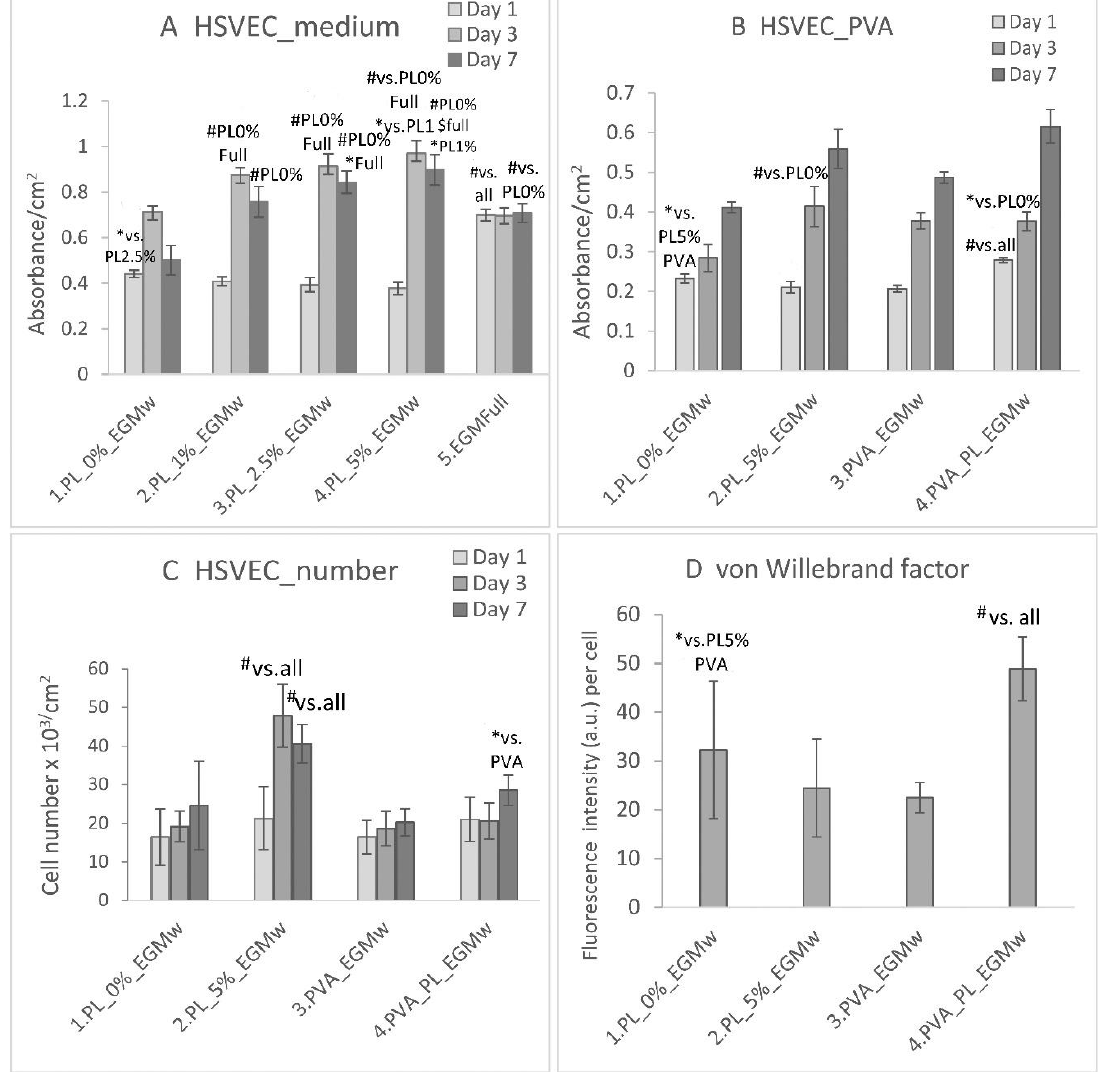
Figure 7. Viability/cm 2 of the human saphenous endothelial cells (HSVECs) in the EGM-weak (EGMw) medium, the EGMw supplemented with 1, 2.5 and 5% PL and the EGM-full medium ( A ). Viability/cm 2 ( B ) and population density/cm 2 ( C ) of the HSVECs in the EGMw medium, the EGMw with 5% of PL, the EGMw with added PVA and PVA–PL nanomats and the EGM-full medium. The cells were cultivated for 1, 3 and 7 days ( A , B ). The intensity of fluorescence of the von Willebrand factor in the HSVECs on day 7 following seeding ( D ). The data are expressed as the mean ± SD, # refers to p < 0.001, $ to p < 0.01, * to p <